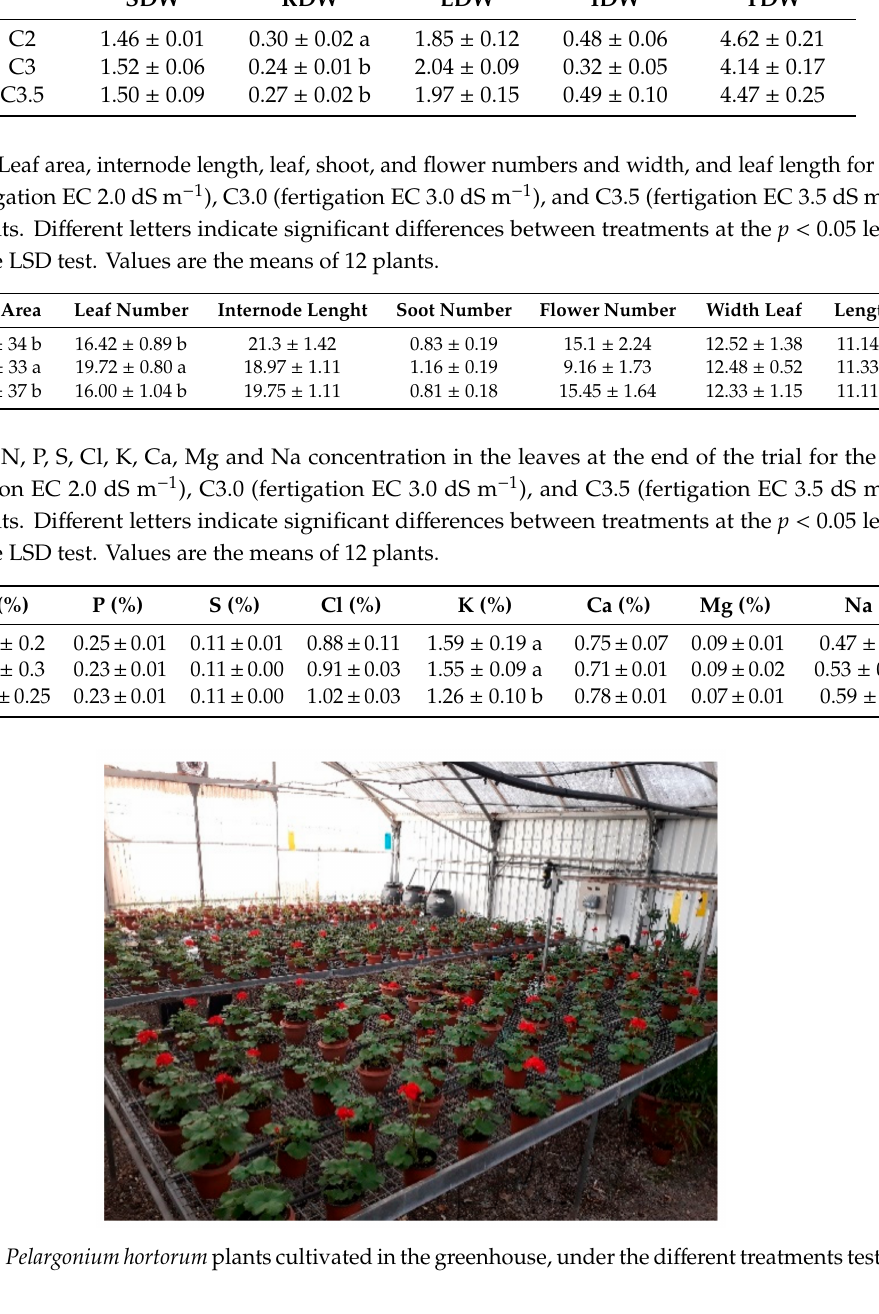
Table 1. DW (g) of S, R, L, I and T at the end of the trial for the C2 (fertigation EC 2.0 dS m − 1 ), C3.0 (fertigation EC 3.0 dS m − 1 ), and C3.5 (fertigation EC 3.5 dS m − 1 ) treatments. Di ff erent letters